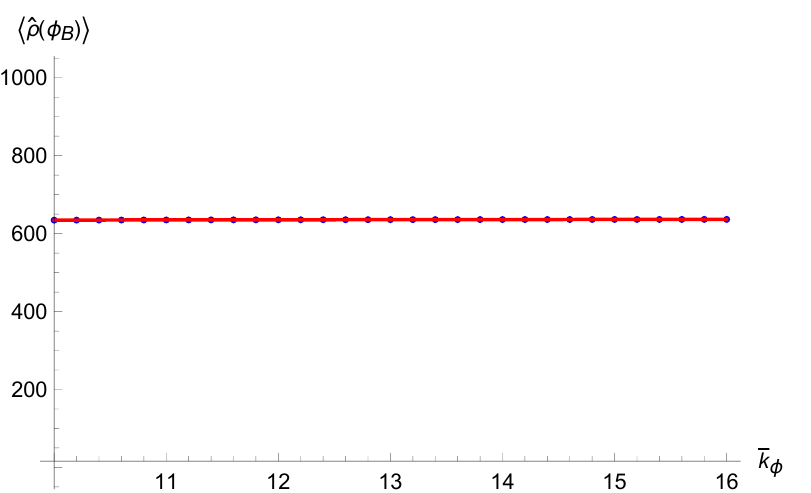
Figure 14. The expectation value of the energy density at the time φ B of the Bounce as a function of k φ (blue dots), fitted with a function in accordance with the semiclassical evolution (continuous red